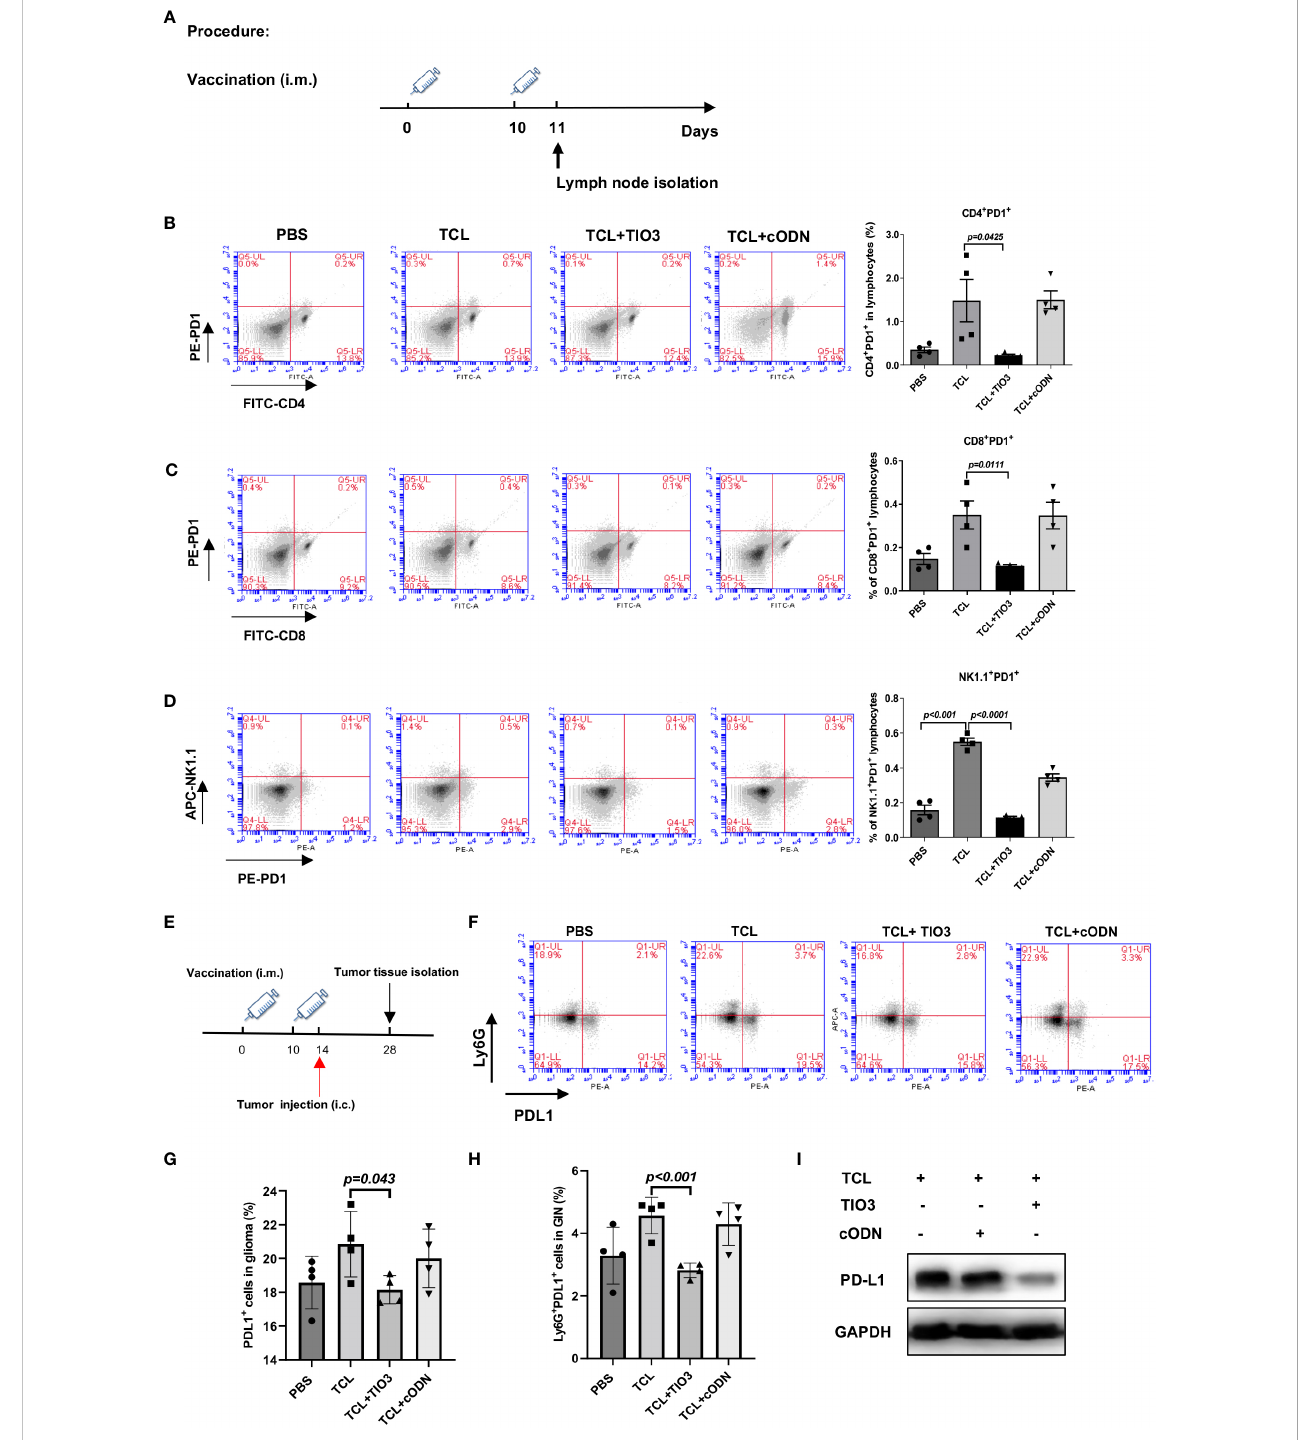
FIGURE 6 Inhibitory effects of TIO3 as glioma vaccine adjuvant on the expression of PD1 and PD-L1 on immune cells and tumor tissues in mice. (A) C57BL/6 mice (n = 4) were intramuscularly injected in the neck with PBS, TCL, TCL+TIO3 or TCL+cODN on day 0 and day 10, and 24h after the second immunization, the lymphocytes isolated from the mice were detected for the expression of PD1 on CD4 + T cells (B) , CD8 + T cells (C) , NK cells (D) . (E) The mice (n=4) were intramuscularly immunized with PBS, TCL, TCL+TIO3 and TCL + cODN in the neck on day 0 and 10, and then and then challenged i.c. with 2×10 4 GL261 cells on day 14, 4 mice were sacri fi ced on day 28. (F-H) Percentage of PDL1 + cells in glioma tissue and glioma in fi ltrating neutrophils (Ly6G + ) (GIN). (I) PD-L1 expression in glioma tissue isolated from the mice on day 28 by western